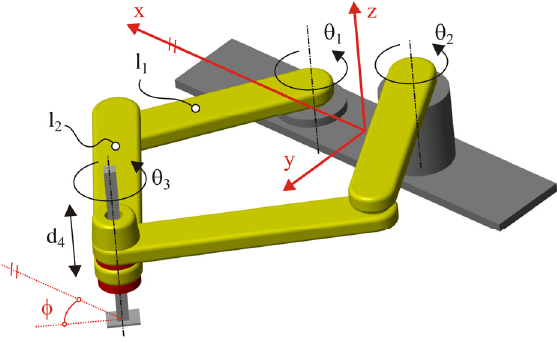
Figure 2. The 4-axis BiSCARA